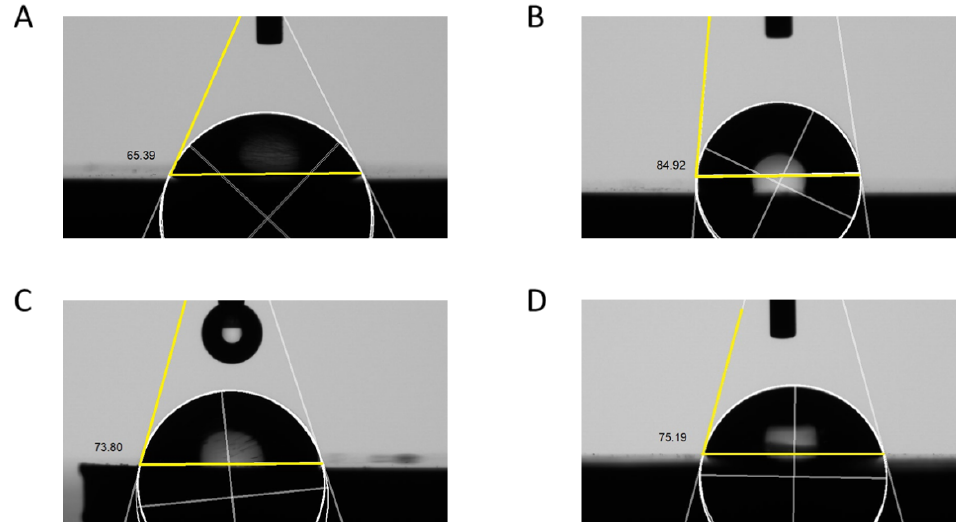
Figure 4. Images of contact angles of the specimens. ( A ) Milled, ( B ) horizontal, ( C ) vertical, and ( D ) tilted.